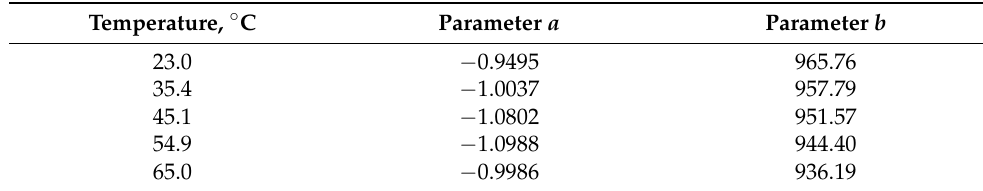
Table 2. Values of parameters a and b , depending on temperature, for lines describing the results of density measurements of mixtures of mineral oil with synthetic ester depending on the mineral oil (MO) concentration.